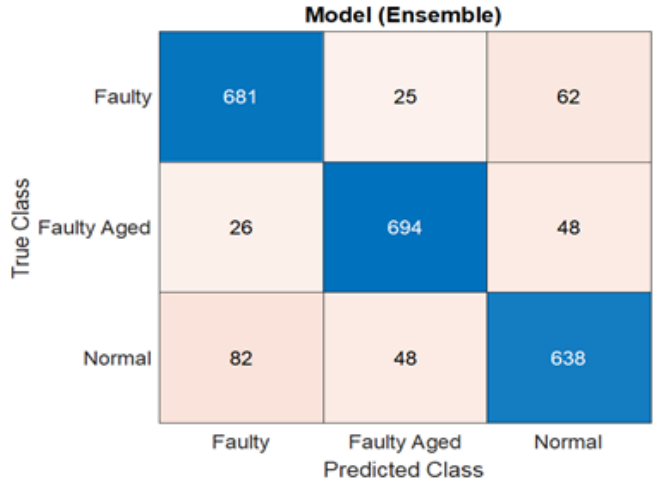
Figure 22. Parallel coordinate plot for the highest-scoring classifier (Ensemble learning) for Hyundai robot fault classification.